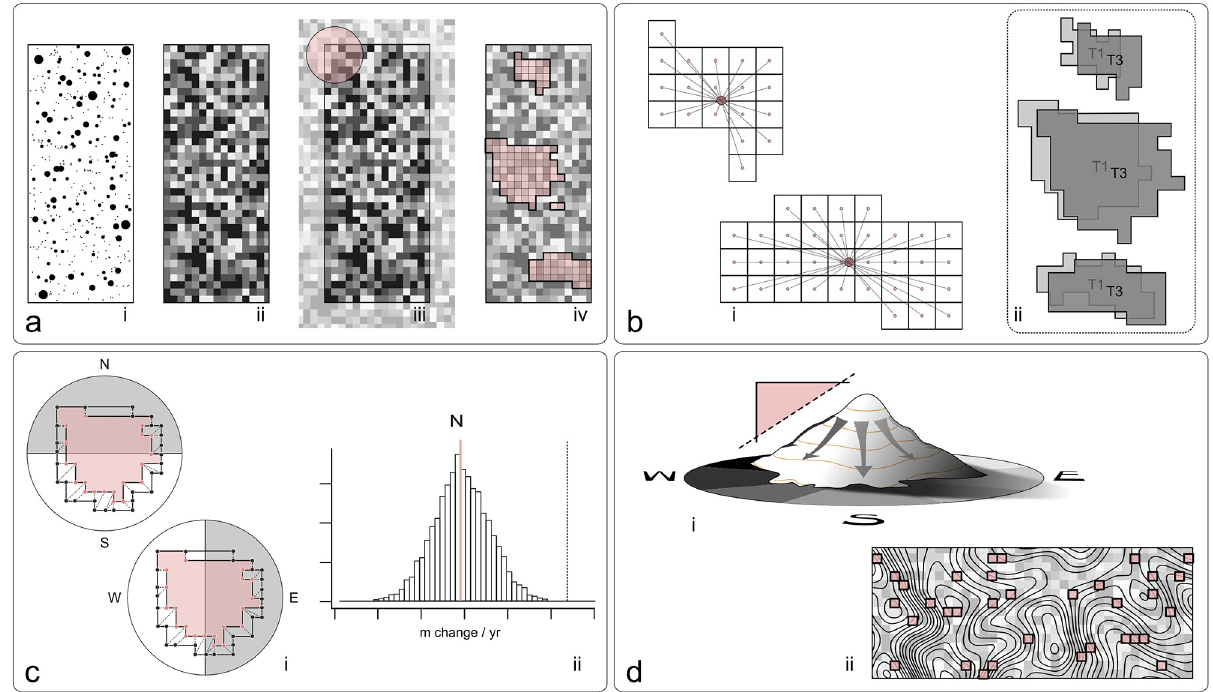
Fig 2. Conceptual diagram of methods employed in this study. (a) Raw tabular data was cleaned and coerced into spatial format (i). Basal area was aggregated to grid cells (ii), whose values were minimally smoothed after accounting for edge effects (iii). Monodominant forest patch delineation was based on isolines of BA intensity (iv). Three different different analytical approaches were then used to evaluate spatial propagation of monodominant forest on each field plot (b-d). (b) Scale-independent radius of gyration was computed for each patch (i), and a patch area-weighted mean was computed for each field plot (ii). The final metrics were used to evaluate change between the first and third censuses. (c) Patch vertices from the first and third censuses were paired based on measures of proximity (i). Regression was used to look at changes in latitude and longitude for each of four cardinal quadrants (i). Permutation testing was used to determine if the linking algorithm was producing demonstrable, non-random measures of change (ii). (d) The difference in basal area intensity between the first and third censuses was treated as a topographic surface from which vector magnitude (slope) and direction (aspect) were derived (i). Spatial bootstrapping of the pixelated difference surfaces was used to evaluate plot-level gains or losses across time